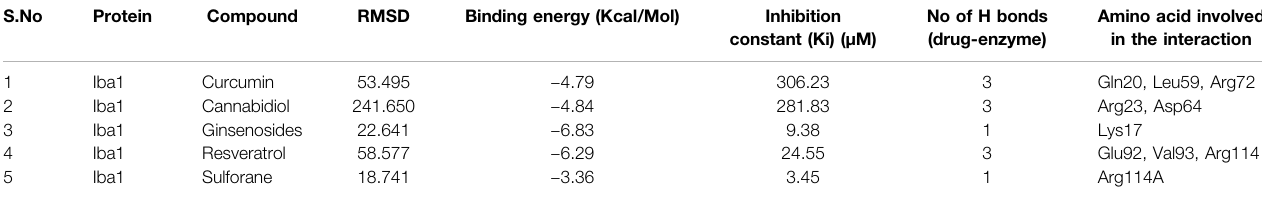
TABLE 2 | Protein-ligand interaction analysis of Iba1 with natural compounds showed the lowest binding energy with Ginsenosides and Resveratrol.